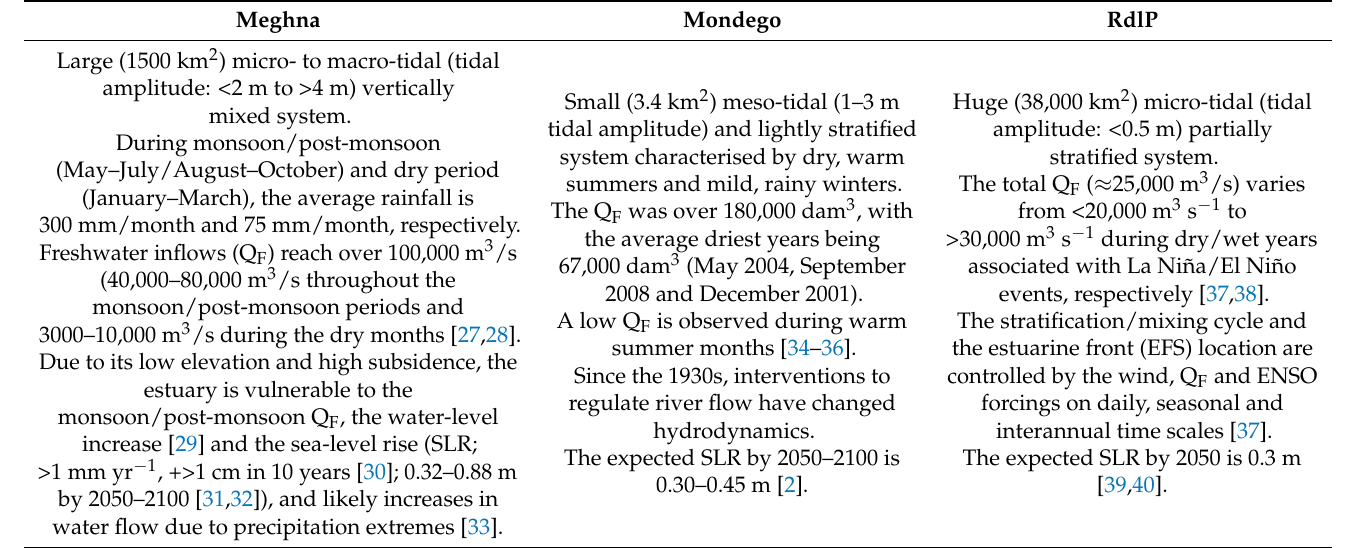
Table 1. Hydrological features of the studied